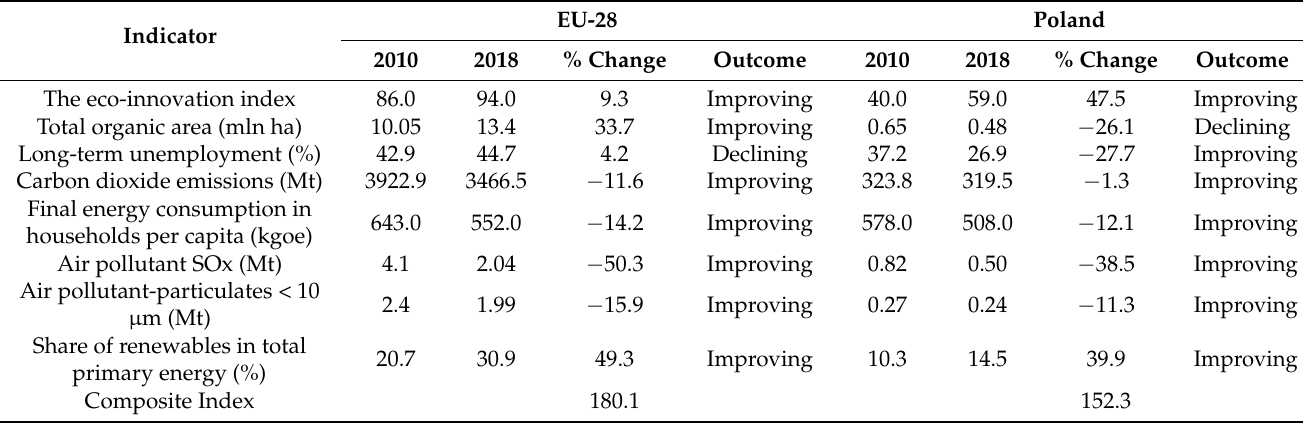
Table 3. Selected indicators of Sustainable Development Goals (SDG), EU-28 countries, and Poland in 2010–2018. Own study, based on [13,31].